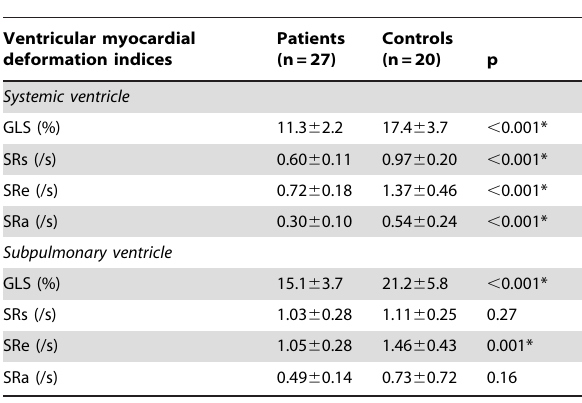
Table 1. Indices of global myocardial deformation of the systemic and subpulmonary ventricles in patients and